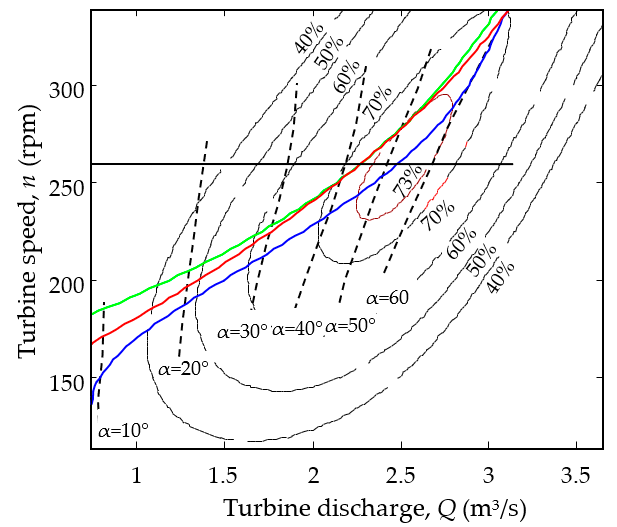
Figure 10. Hill charts of an experimental turbine showing the optimal measured operating curve (solid blue line), calculated performance curve using the simplified formula (solid green line), revised formula (solid red line) and constant speed curve (solid black line).